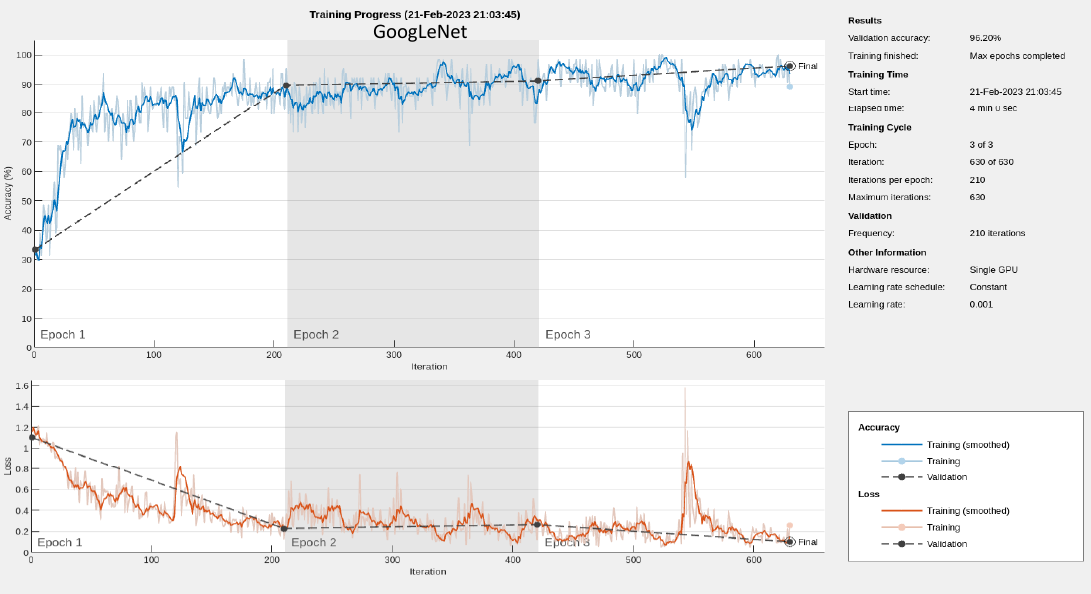
Figure 8. Accuracy and loss of training progress in the GoogLeNet from scratch (no transfer learning).